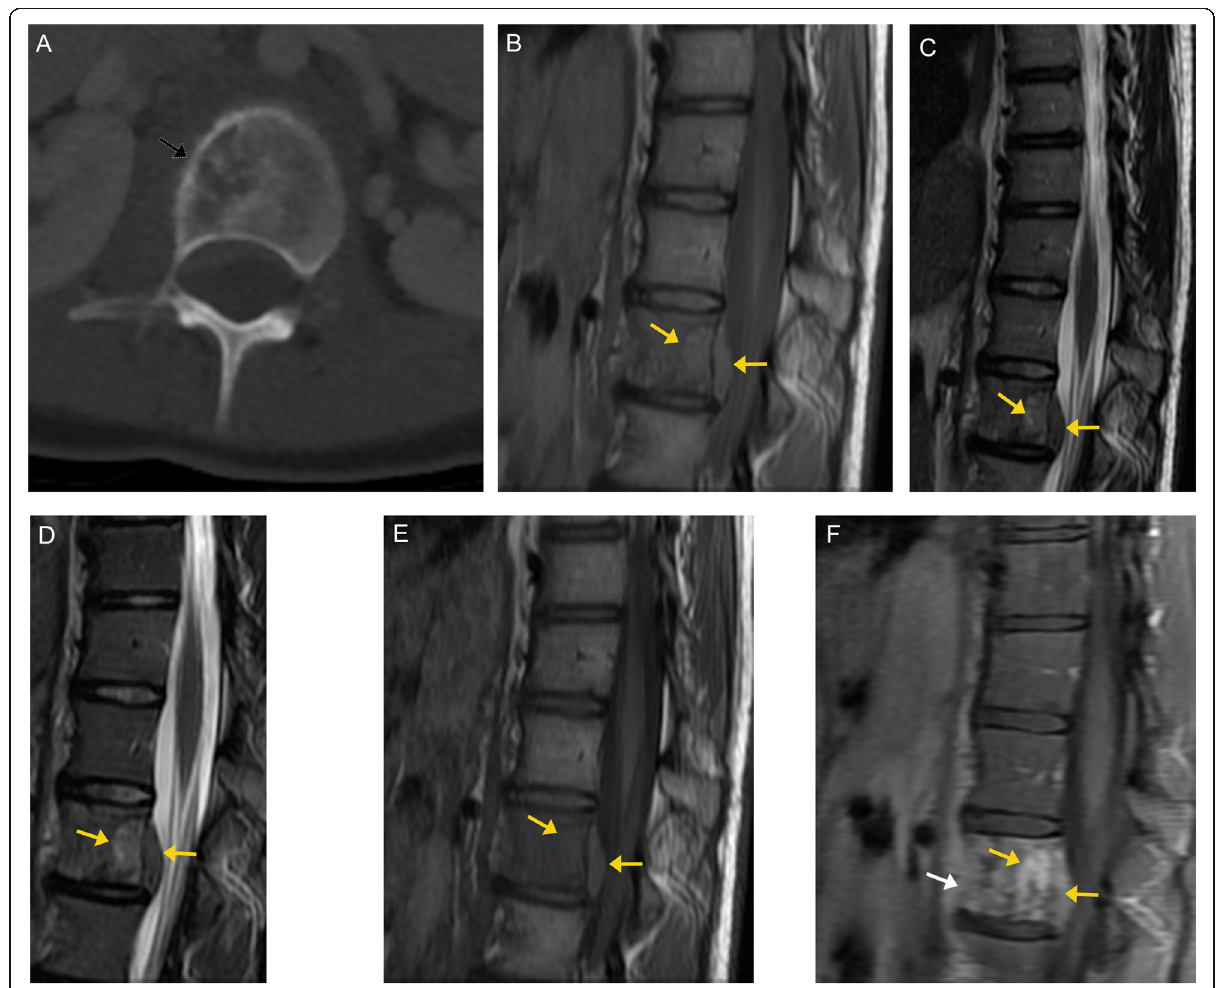
Fig. 20 Ewing ’ s sarcoma. Axial CT image in the bone window ( a ) demonstrates an ill-defined lesion with destructive changes of the right vertebral body. The bone cortex has a “ smudged ” appearance (black arrow) due to perforation of tumor through the cortex. Sagittal proton-density image ( b ) demonstrates the ill-defined tumor as abnormal marrow signal with epidural extension (orange arrows). Sagittal T2- weighted ( c ) and T2 fat-saturated ( d ) images demonstrate variable signal within the lesion (orange arrows). This lesion demonstrates low to intermiediate T1 signal ( e , orange arrows). On T1-weighted post-contrast imaging ( f ), there is heterogenous enhancement of the tumor (orange arrows), which is difficult to distinguish from the enhancing peritumoral edema (white